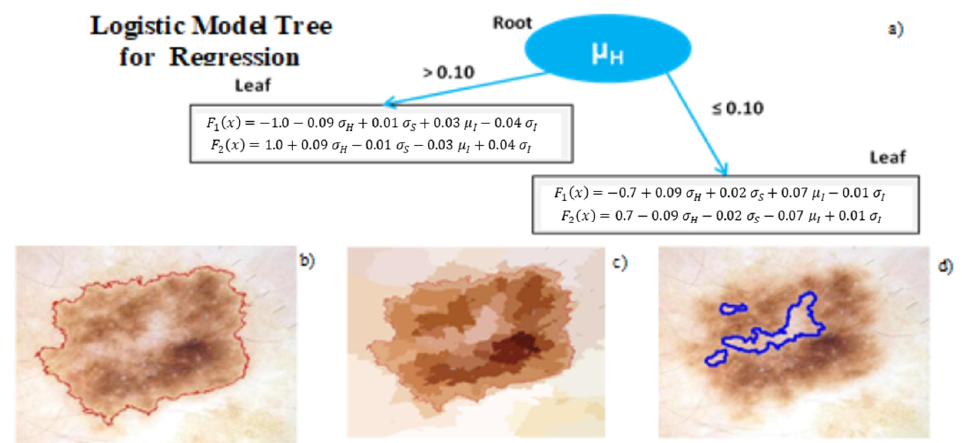
Figure 3. ( a ) Logistic model tree (LMT) for classification with respect to regression; ( b ) epiluminescence microscopy (ELM) image and contour; ( c ) lesion map; ( d ) detection results.